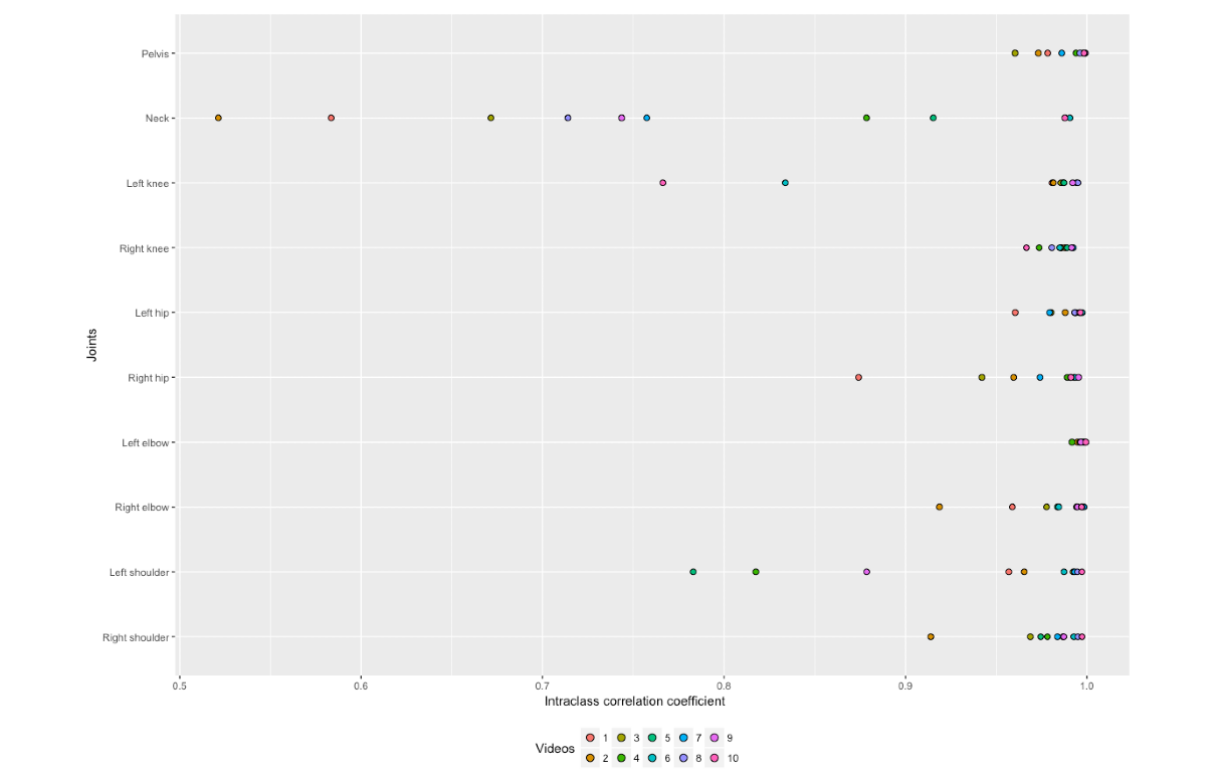
Figure 4. Dot plot of the intraclass correlation coefficient comparing Lindera-v2 and reference standard for the 10 single videos used for accuracy measurement in each